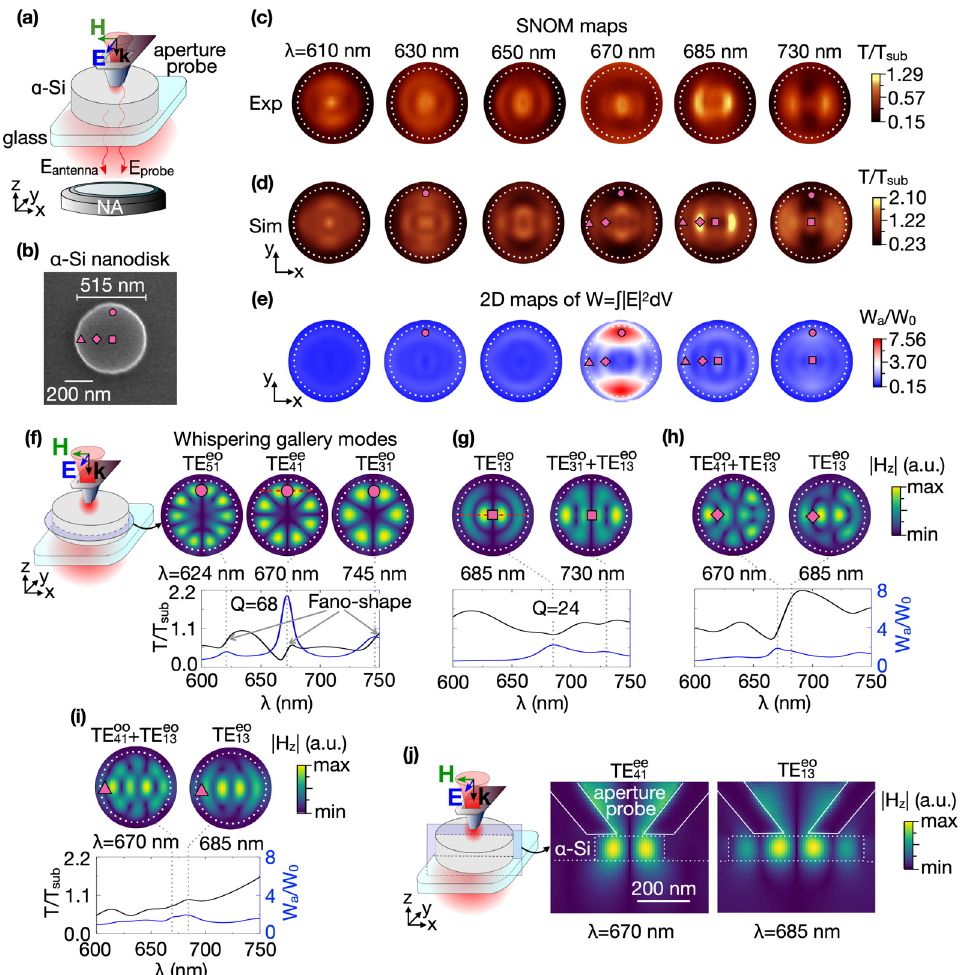
Figure 1: (a) Schematic representation of the near-field mapping of optical modes in the 𝛼 -Si nanodisk. (b) SEM image of the 𝛼 -Si nanodisk. The diameter is 515 nm, and the thickness is 96 nm. Experimental (c) and simulated (d) SNOM maps of the 𝛼 -Si nanodisk at different wavelengths. The polarization of light incident on the SNOM probe (blue arrow) is directed along the y − axis. (e) Simulated 2D maps of electric field localization W /W at the same wavelengths as in the SNOM maps in (c) and (d). The circle ( x = 0 nm, y = 220 nm), square 0 a ( x = 0 nm, y = 0 nm), diamond ( x = 120 nm, y = 0 nm), and triangle ( x = 240 nm, y = 0 nm) symbols on 2D maps in (b), (d), and (e) depict /W . (f–i) The simulated SNOM transmittance T / T the SNOM probe positions corresponding to maxima of the electric field localization W 0 sub a (black curves) and electric field localization W /W (blue curves) spectra recorded at the fixed positions of the SNOM probe marked as 0 a | distributions of TE ij | /W (e) maps. The top row in (f–i) shows the simulated | H optical modes. The | H purple symbols on SNOM (d) and W 0 a z z mn | distributions of TE ee and TE eo optical field was taken at central xy − cross-sections of the nanodisk as shown in the sketch in panel (f). (j) | H z 41 13 modes at xz − cross-section (see schematic illustration in the sketch). The positions of xz − plane cuts are marked by red dashed lines in (f) and (g). Dotted white circles indicate the boundary of the nanodisk. The solid white lines indicate the edges of the aperture SNOM probe.